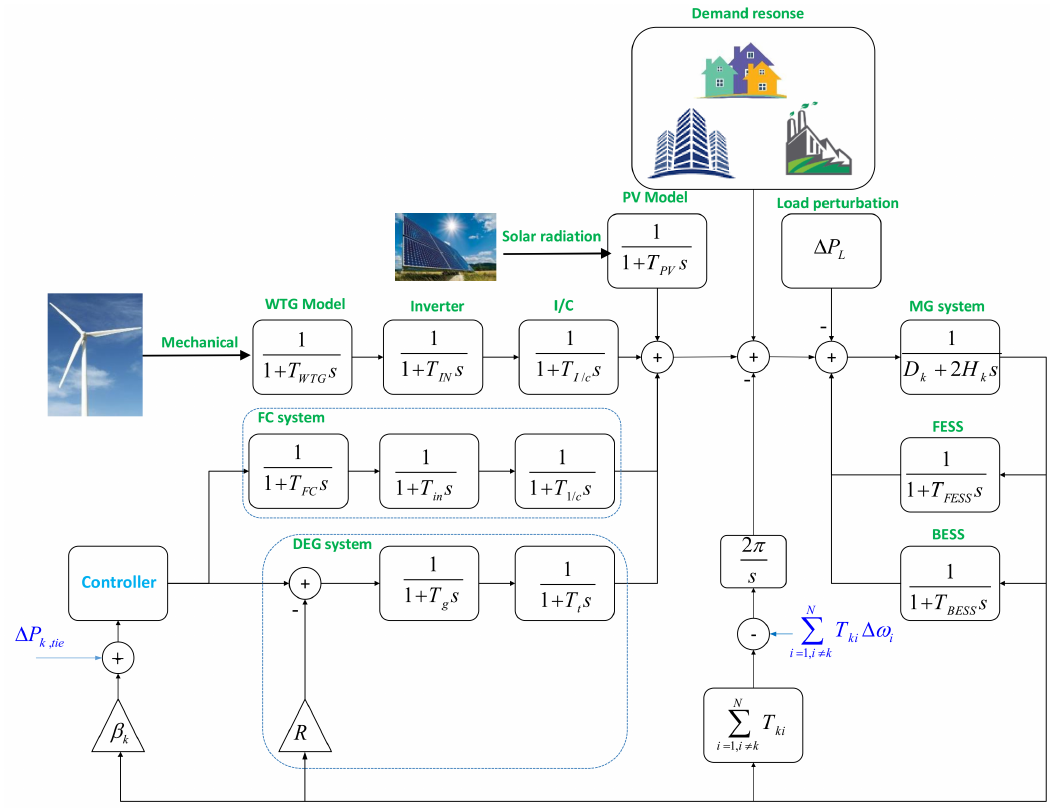
Figure 2. The general diagram of case